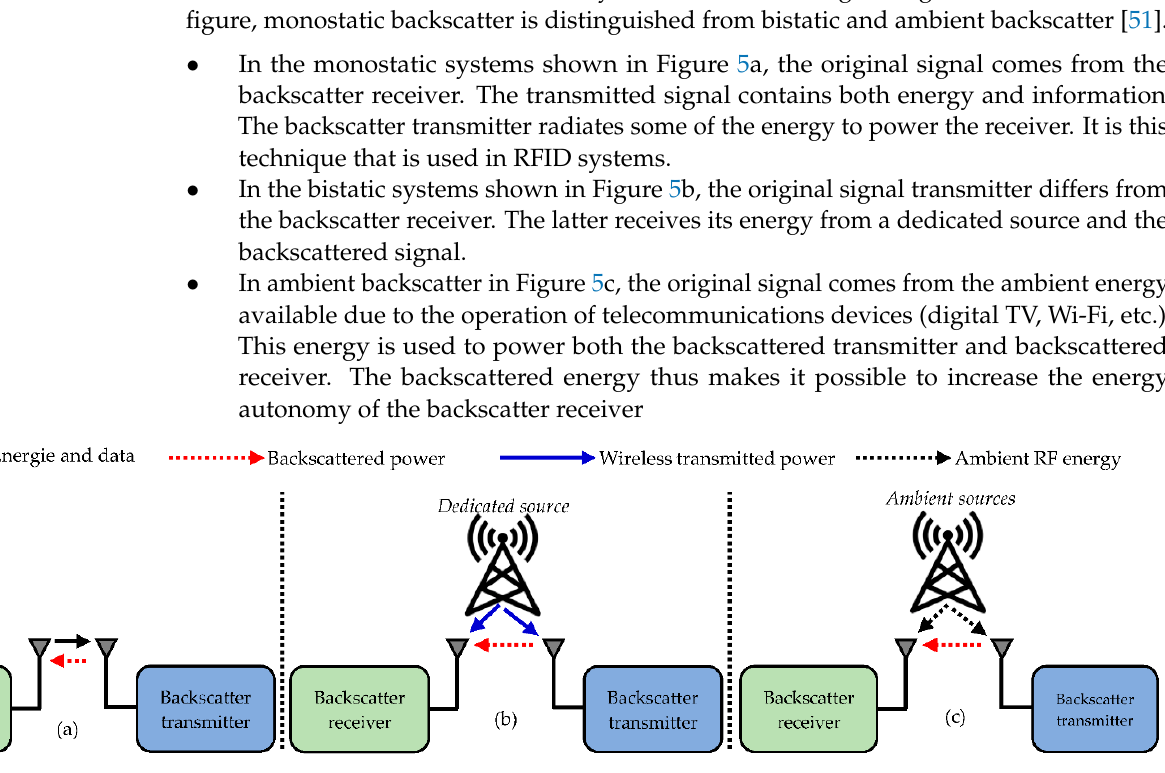
Figure 5. Different types of backscatter communications systems. ( a ) Monostatic. ( b ) Bistatic. ( c ) Ambient.